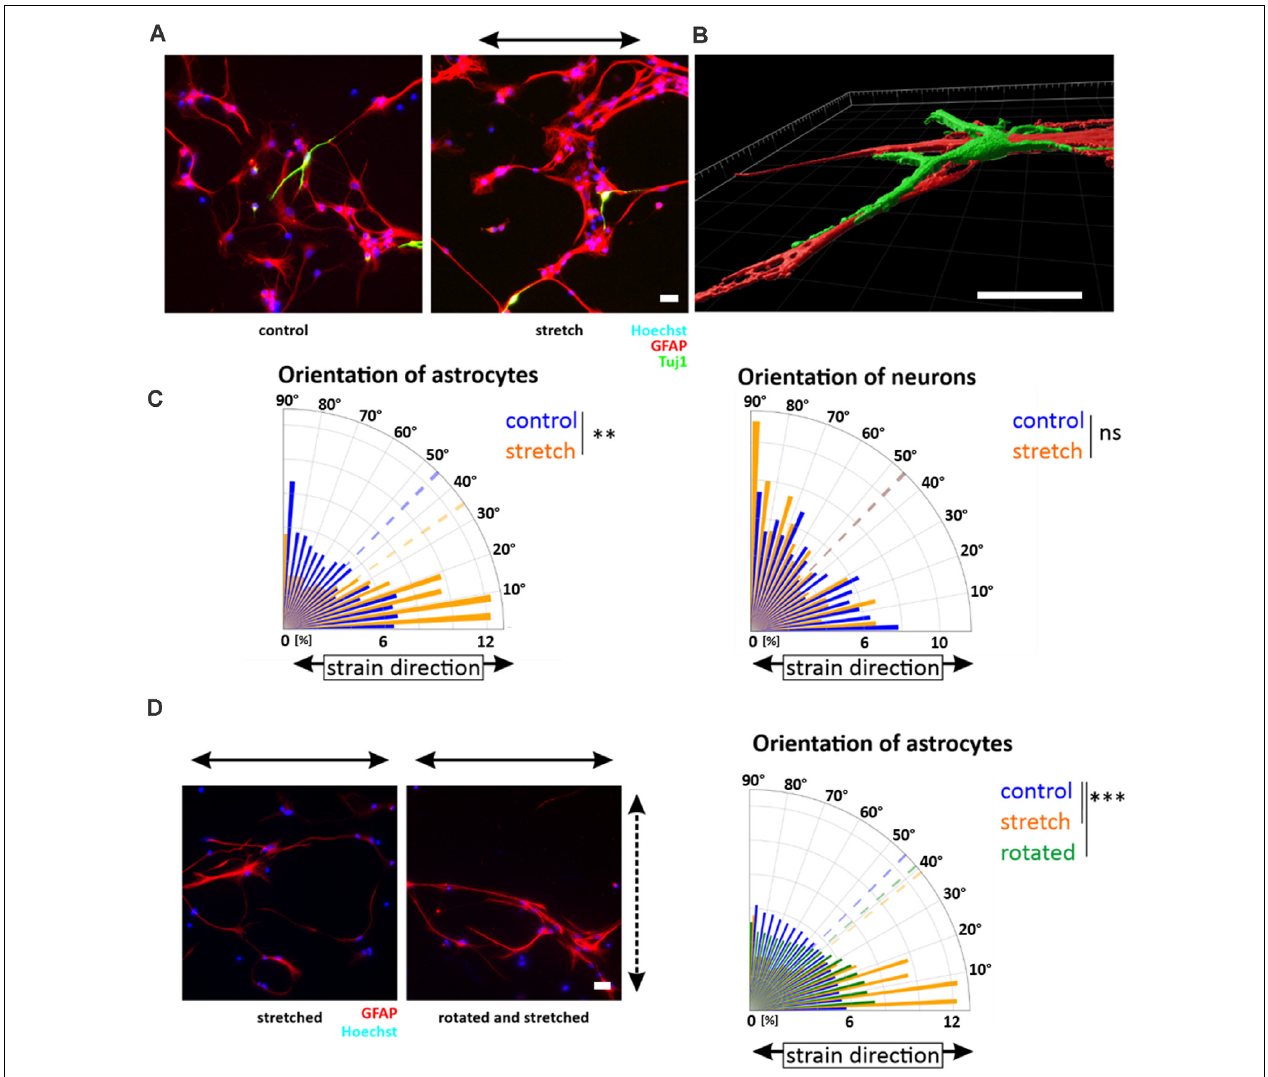
FIGURE 4 | Orientation of NSC-derived young neurons and -astrocytes. Upon mitogen withdrawal, differentiating NSCs were stretched for 5 days or grown on elastomer chambers as a control. After 5 days, cells were fixed and stained against GFAP (astrocytes) and Tuj-1 (neurons) (A) . Images were taken with an LSM 880 and processed with the Imaris software (B) . Orientation plots are representative plots obtained from pixels stained with GFAP or Tuj-1 and their control (C) (mean orientation of stretched young astrocytes vs. control p -value = 0.005, n = 8 independent experiments from different passages indicated as the dashed line; mean orientations of young neurons in the control and stretch are overlapping). (D) After 3 days of stretch, differentiating young astrocyte cultures were removed from their chamber holders and rotated by 90 degrees. The dashed arrow indicates the stretch direction of the first 3 days; the black arrow indicates the stretch direction of the last 2 days. The orientation plot shows the shift of orientation towards smaller angles with significant mean orientations indicated as dotted lines ( p -value control vs. rotated = 0.0003; p -value control vs. stretch = 0.0002, n ≥ 8 independent experiments from different passages). Scale bars = 20 µ m. ∗ define significant differences (see “Material and Methods” section). ns =